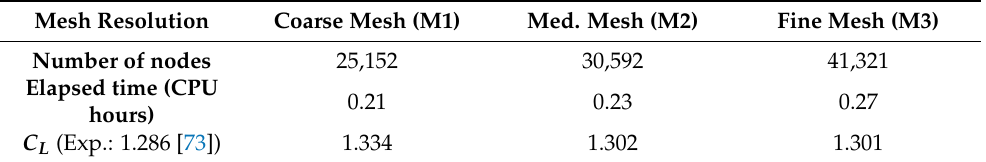
Table 2. Mesh size, elapsed time, and calculated values of C L for validation and convergence analysis on a single